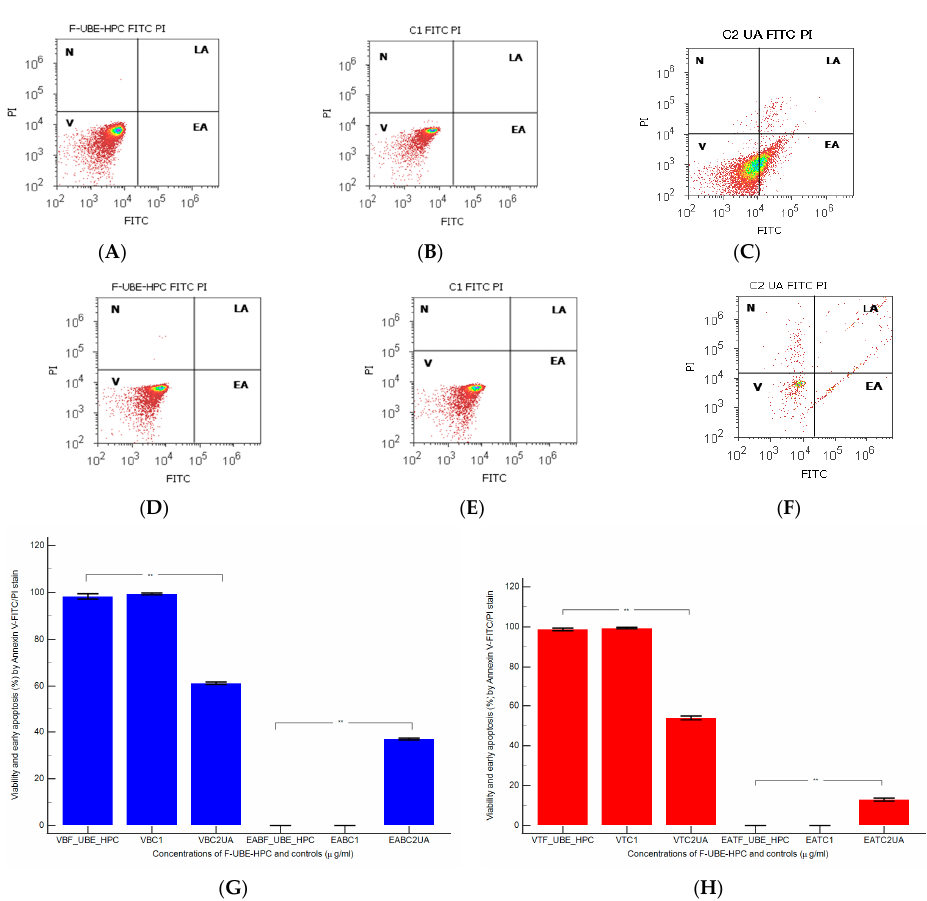
Figure 13. Cell apoptosis after 24 h treatment with F-UBE-HPC in normal blood cells ( A – C ) and CLS-354 tumor cells ( D – F ); annexin V-FITC/PI patterns of F-UBE-HPC ( A , D ); 1%DMSO negative control ( B , E ); 125 µg/mL UA positive control ( C , F ); statistical analysis of cell apoptosis ( G , H ) in normal blood cell cultures and ( B ) CLS-354 tumor cell line ( H ), * * p < 0.01 represents significant statistical differences between controls and sample made by paired samples t -test; V—viability; EA—early apoptosis; C1—negative control with 1% dimethyl sulfoxide (DMSO);